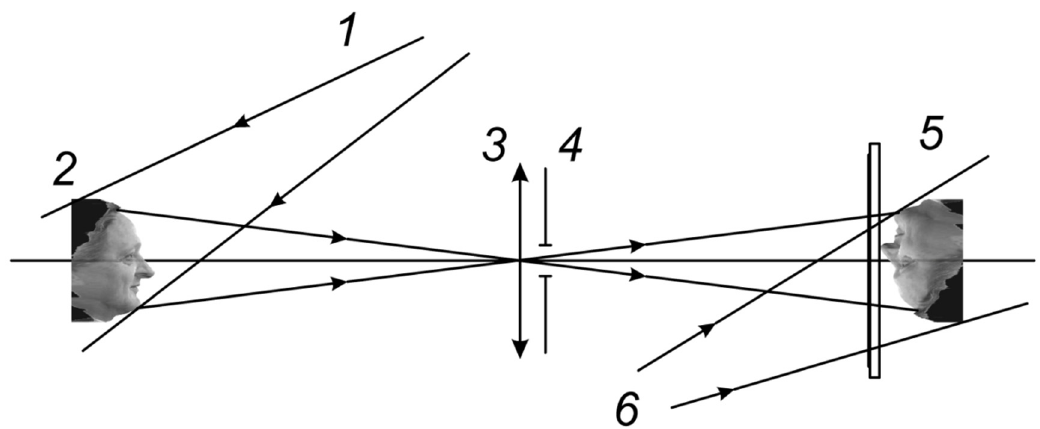
Figure 2. A schematic of one-step recording of a rainbow hologram, according to the method proposed by S. Benton: 1 – radiation of the object backlighting, which is coherent with the reference beam 6 , object 2 , holographic plate 5 , lens 3 , and the filter of vertical spatial frequencies 4 .